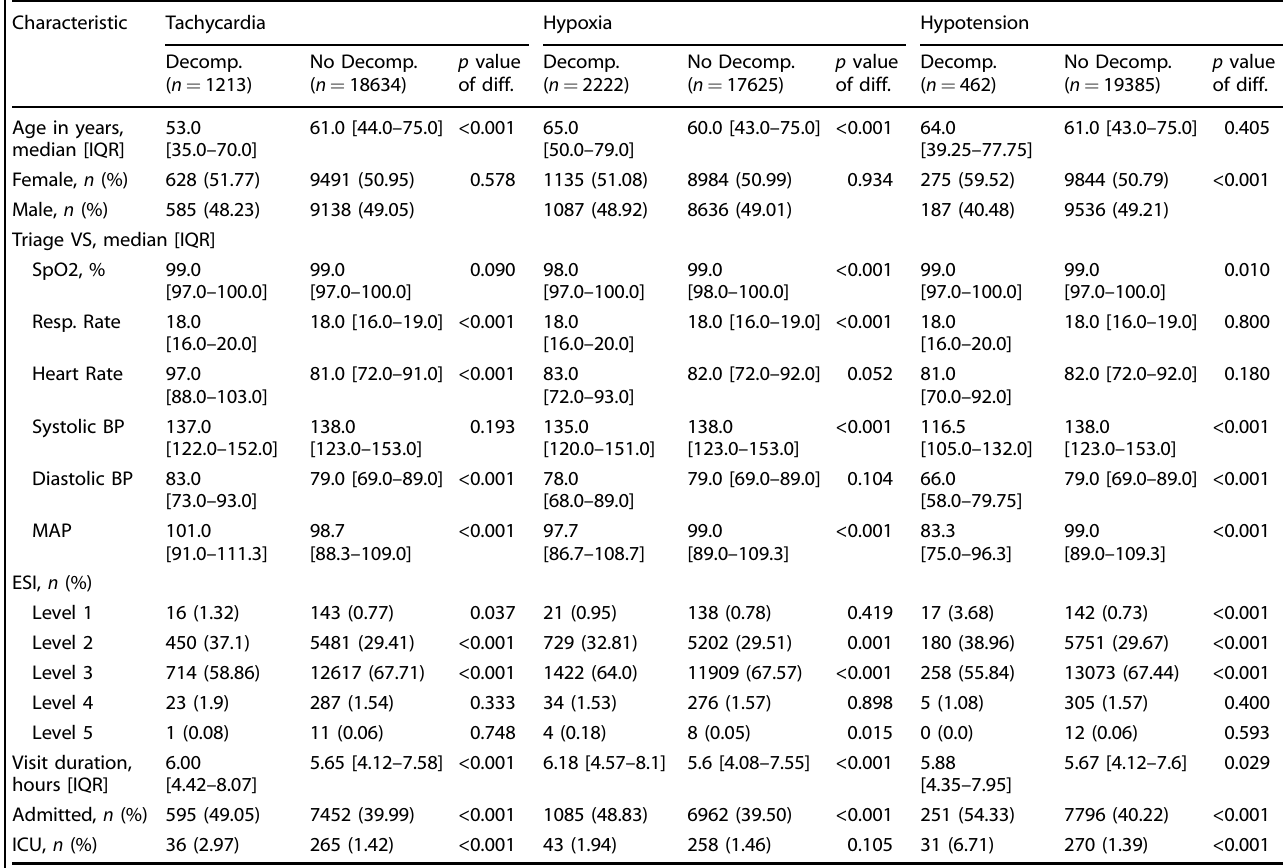
Table 1. Characteristics of visits for each prediction